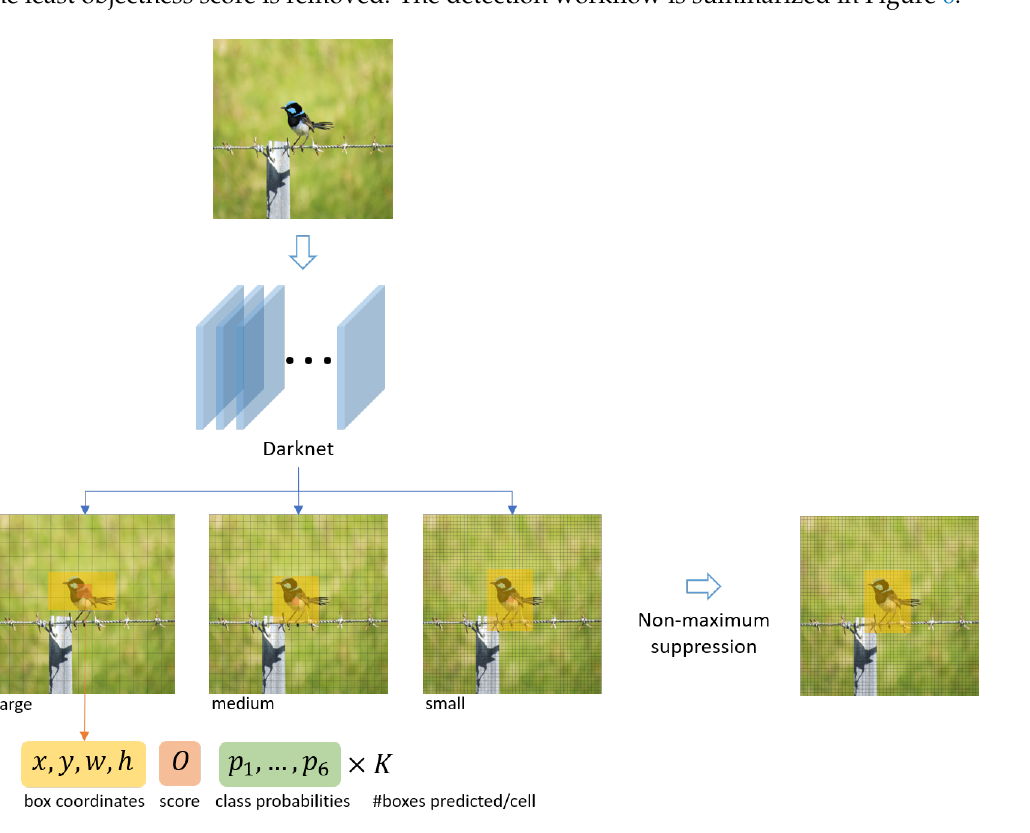
Figure 6. Architecture of YOLO V3 for object detection. A picture is passed through a fully convolutional neural network of 406 hidden layers in order to predict box coordinates and class probabilities at three different scales (large, medium, small). A non-maximum suppression algorithm is then applied to only retain the category and coordinates with the higher score.